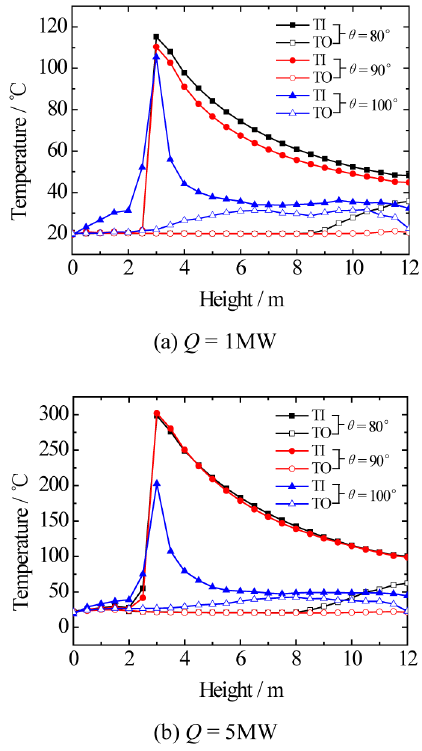
Fig. 10. Vertical temperature at the steady state next to the inner and outer panes with the outer pane tilt angle of 80°, 90° and